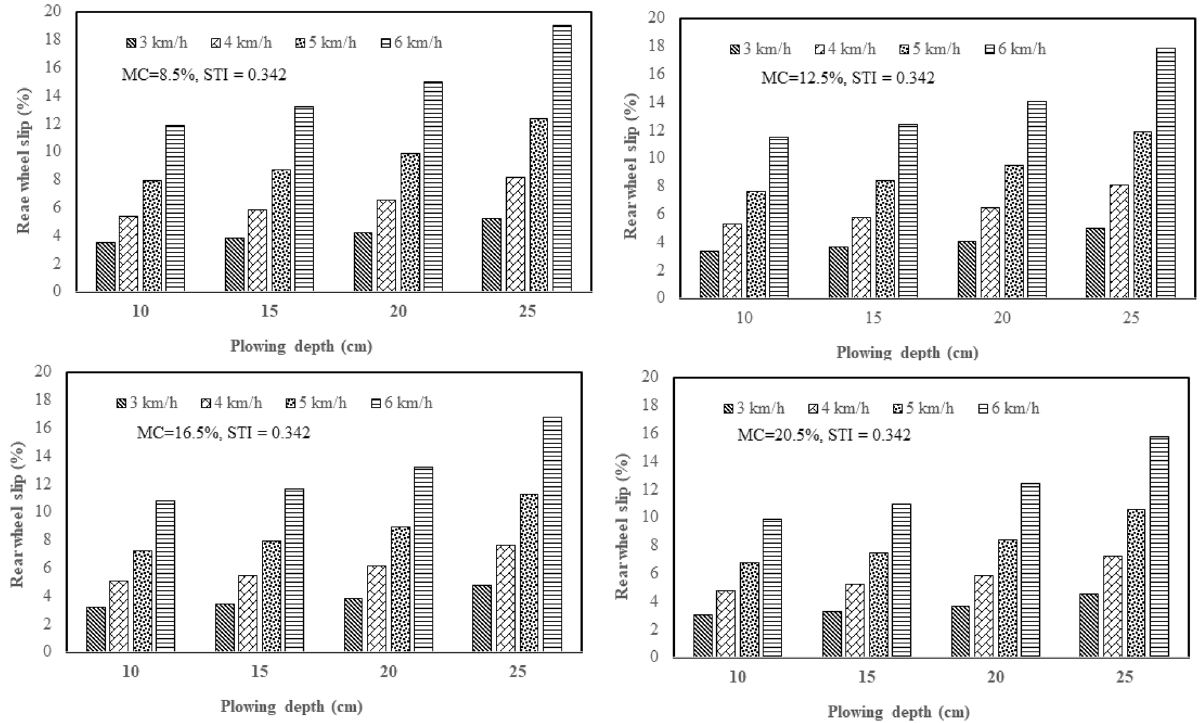
Figure 7. Effect of plowing speed and depth on the tractor rear wheel slip in 2WD mode at different levels of soil moisture content during plowing process by moldboard plow in soil with a texture index of 0.342.